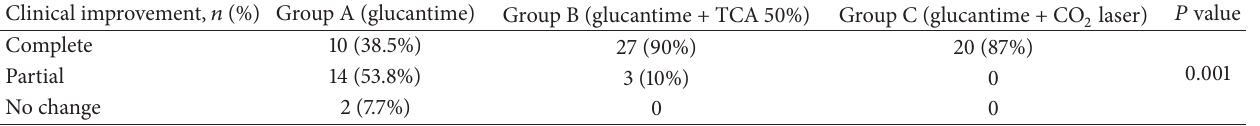
Table 2: The overall clinical